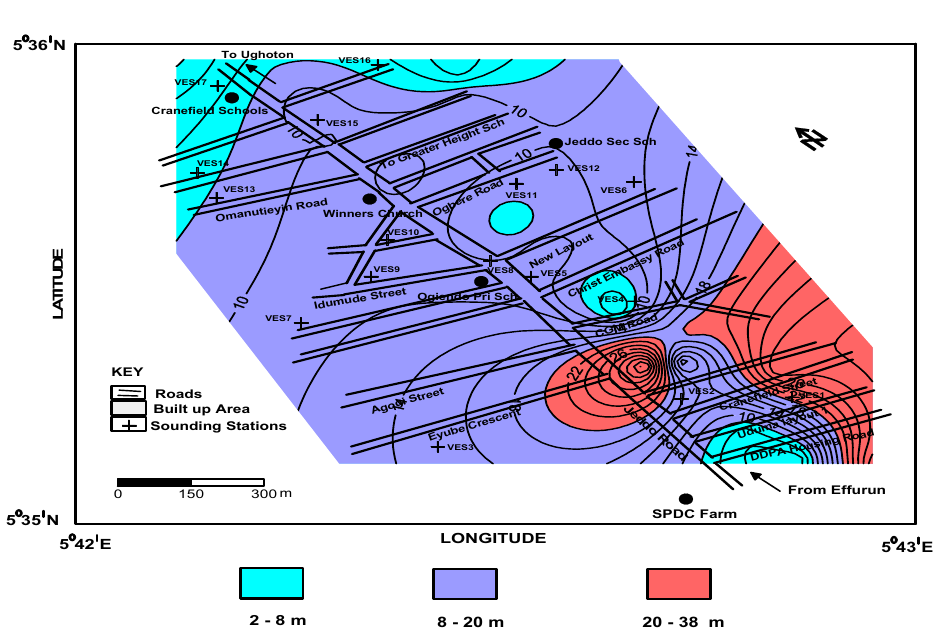
Figure 9. Map of depth to the aquifer.